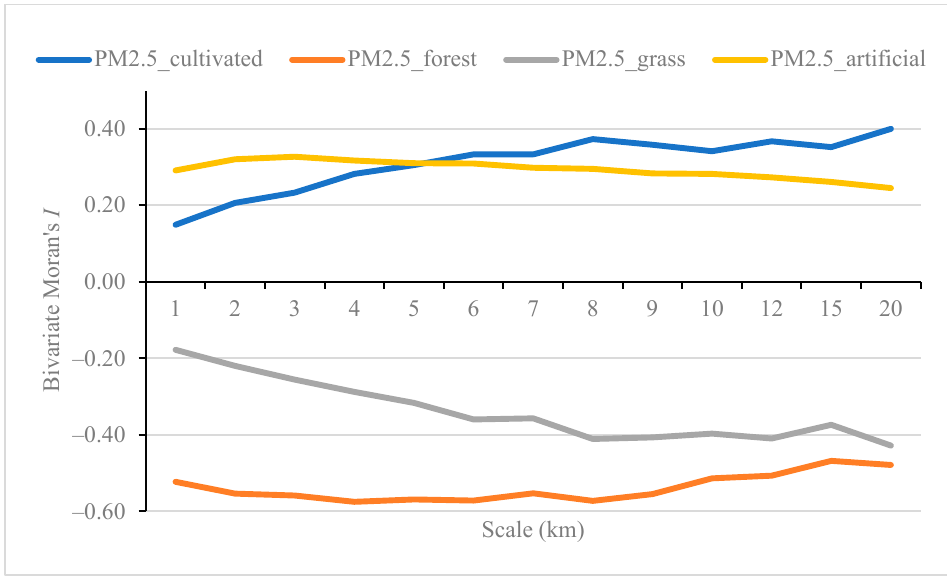
Figure 3. Scale differences in spatial associations between PM 2.5 concentrations and land use.